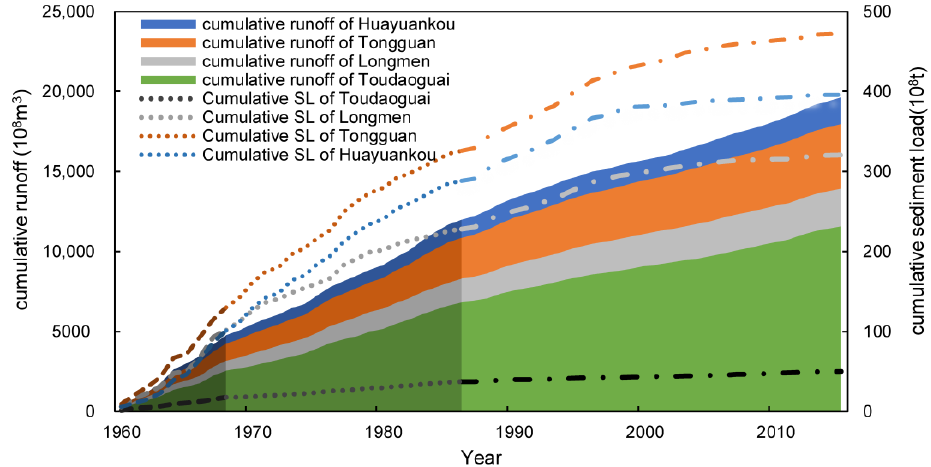
Figure 7 . Cumulative runoff and sediment load (SL) from 1960 to 2015.